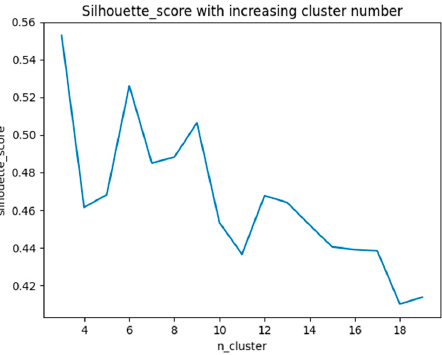
Figure 12. Variation in silhouette_score with the number of clusters for the K-Means++ clustering algorithm.